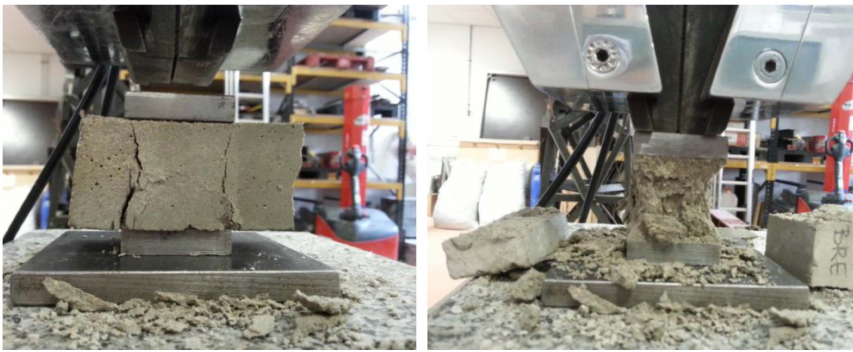
Figure 12. Failure patterns of compression tests.